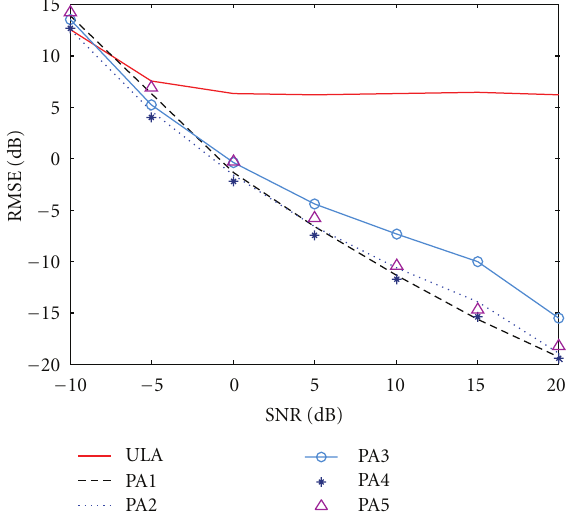
Figure 8: Total RMSE of the MUSIC algorithm for di ff erent configurations where signals are arriving at boresight and endfire